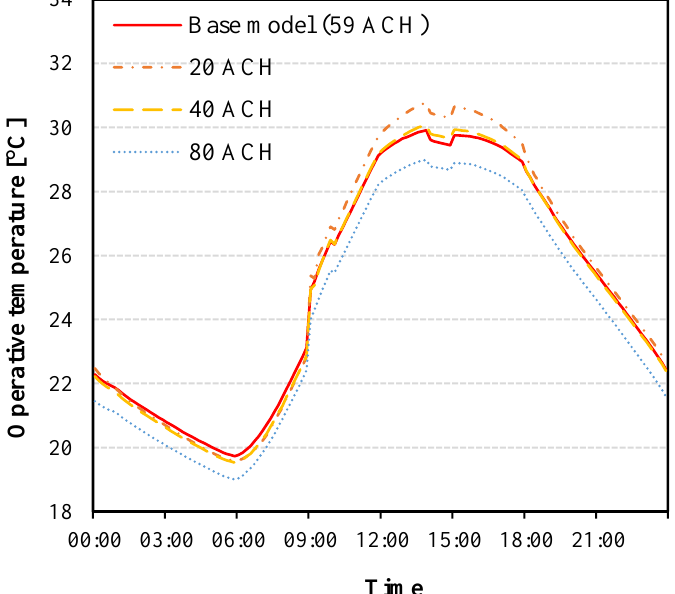
Figure 12. Impact on operative temperature due to natural ventilation.